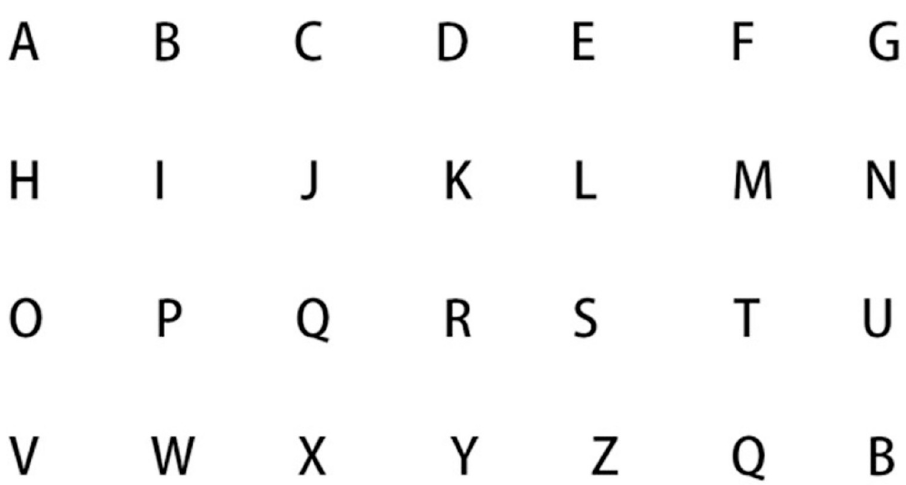
Fig 2. The sample picture used to inform participants of the experiment procedure before memory